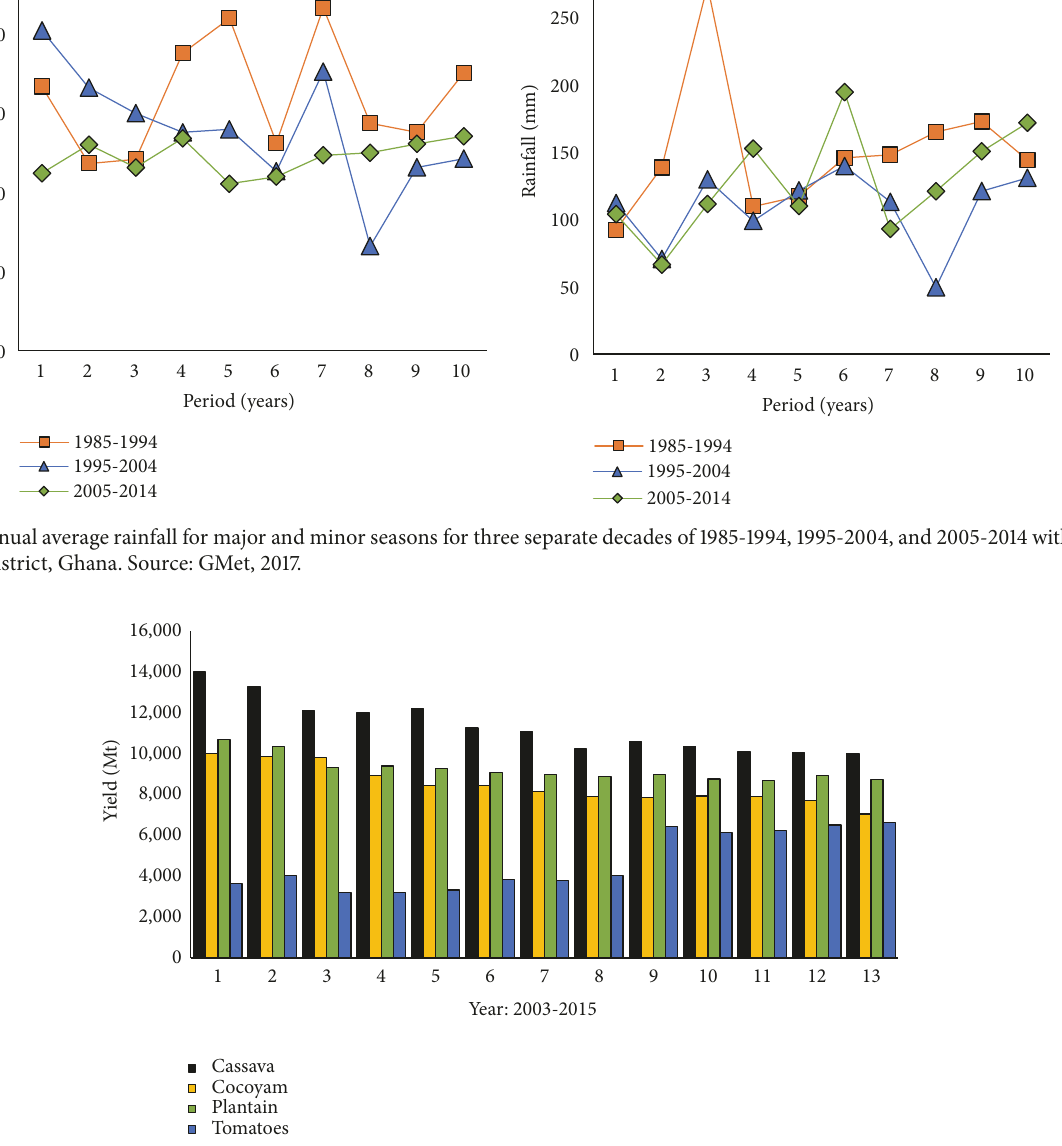
significant variation in both seasons with the highest in the minor season (CV, 5.7%) compared to the major (CV,